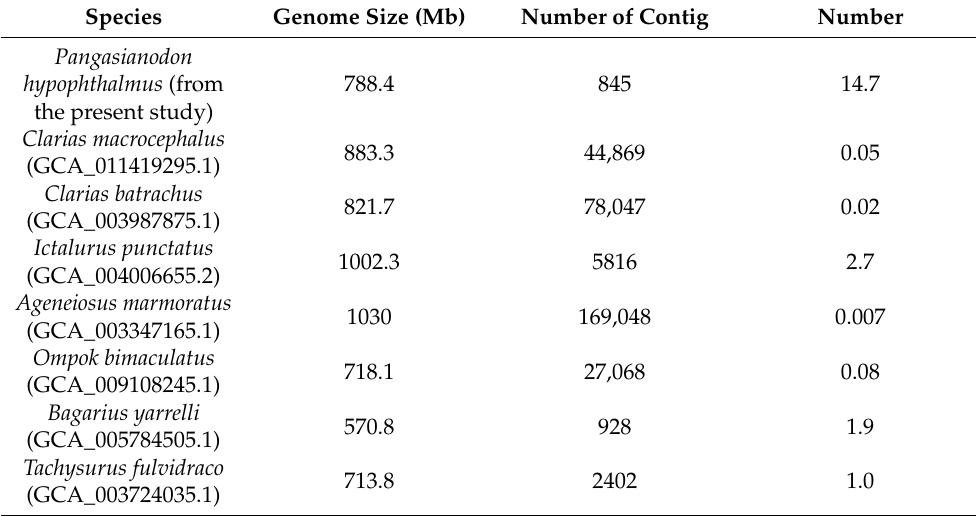
Table 5. Comparison of the genome assemblies of various Siluriformes